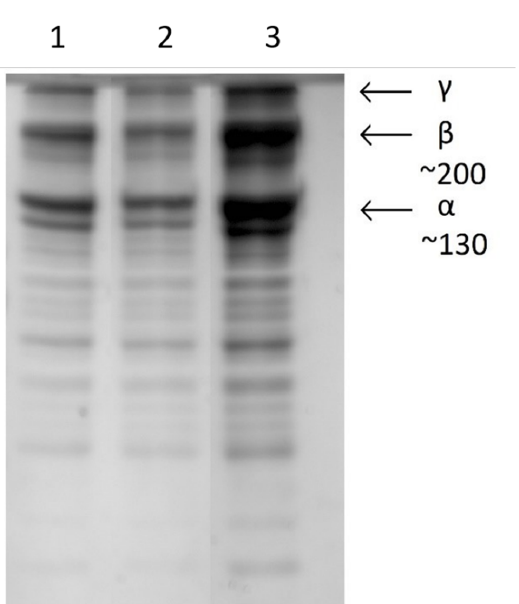
Figure 8. Gel electrophoresis collected from sprayed liquid collagen without plasma (1), plasma deposited collagen (2), and concentrated collagen control sample (3).